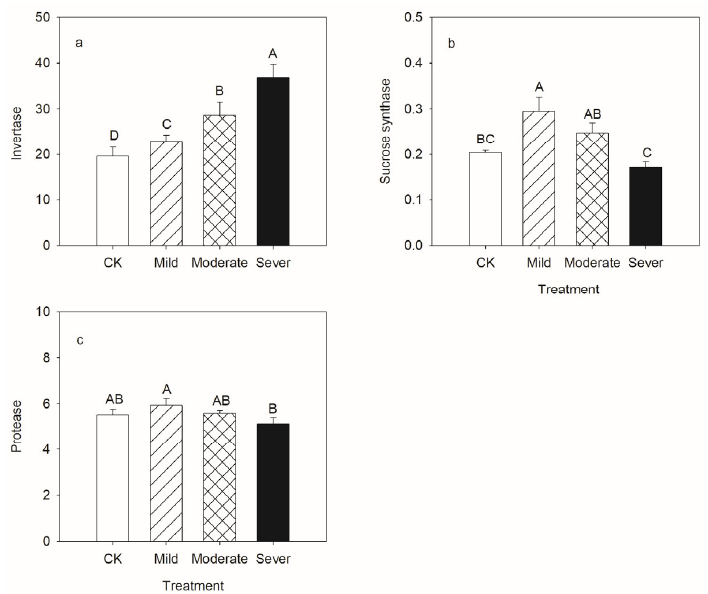
Figure 2. Effects of different levels of salt stress (CK, mild, moderate, and severe) on neutral invertase activity ( a ), sucrose synthase activity ( b ), and neutral protease activity ( c ). Values are means ± SEs. Significant differences between different levels of salt stress are indicated by uppercase letters ( p < 0.05). Table 2. Correlation analysis of physiological characteristics and soil N under different salt stresses.